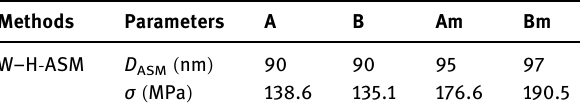
Table 3: Sizes of crystallites and micromechanical constraints